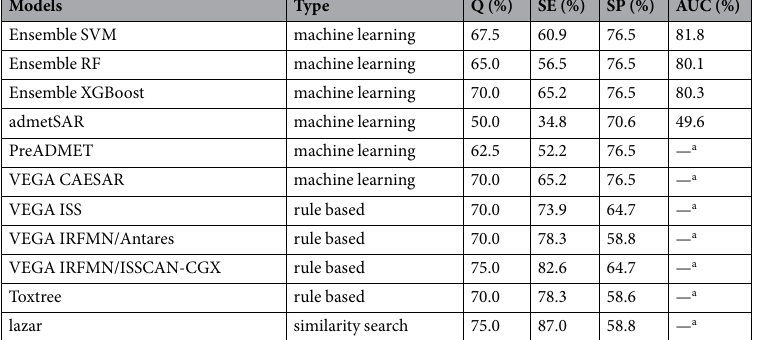
Table 3. Performance of ensemble models and some existing software in the external validation dataset. a The AUC cannot be calculated for this software because there are no probability values in its results.